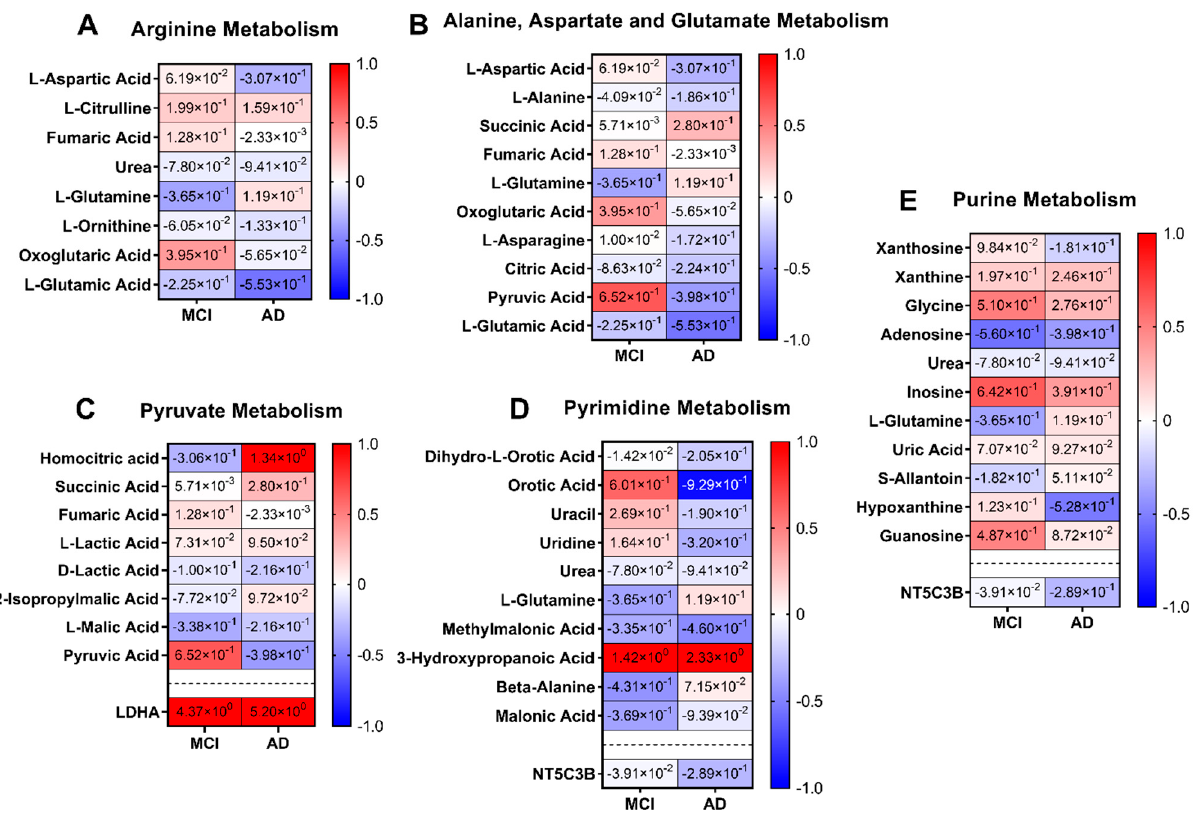
Figure 6. Heatmaps of metabolic pathways. Heatmaps showing metabolomic and proteomic expressions during ( A ) arginine metabolism, ( B ) alanine, aspartate, and glutamate metabolism, ( C ) pyruvate metabolism, ( D ) pyrimidine metabolism, and ( E ) purine metabolism in the plasma matrix of AD and MCI patients compared with CN individuals. The metabolites and proteins used in the multi-omics integration were selected based on the fold changes (Log 2 FC ≥ 1.00 or Log 2 FC ≤ − 1.00) with statistically significant different false discovery rates (FDR ≤ 0.05)). The heatmaps were graphed by manually inputting the fold changes into GraphPad Prism 9.